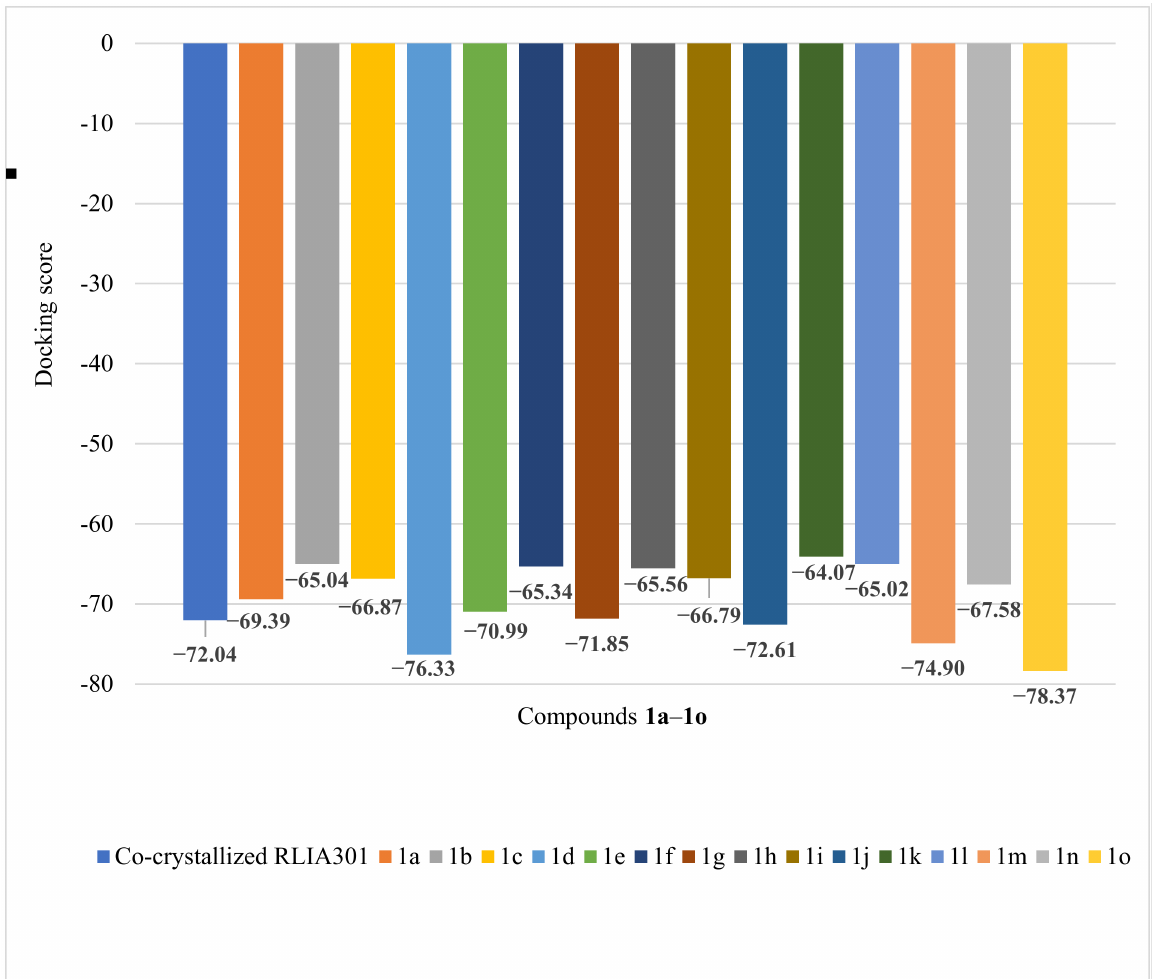
Figure 11. Docking score obtained for the docked compounds 1a – 1o and the target protein